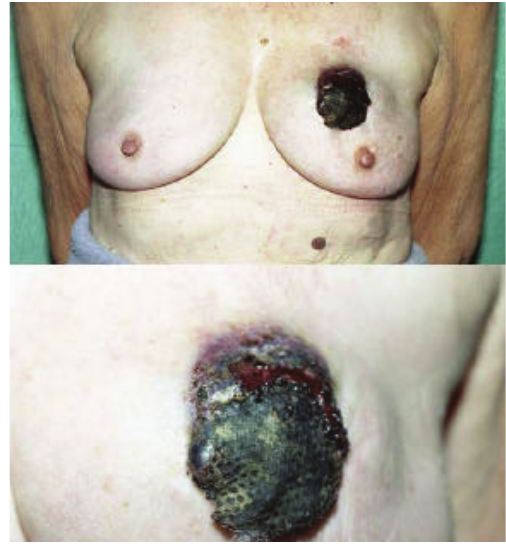
Figure 1: An ulcerated bruise-like lesion in the left breast, consistent with the typical appearance of a breast angiosarcoma.